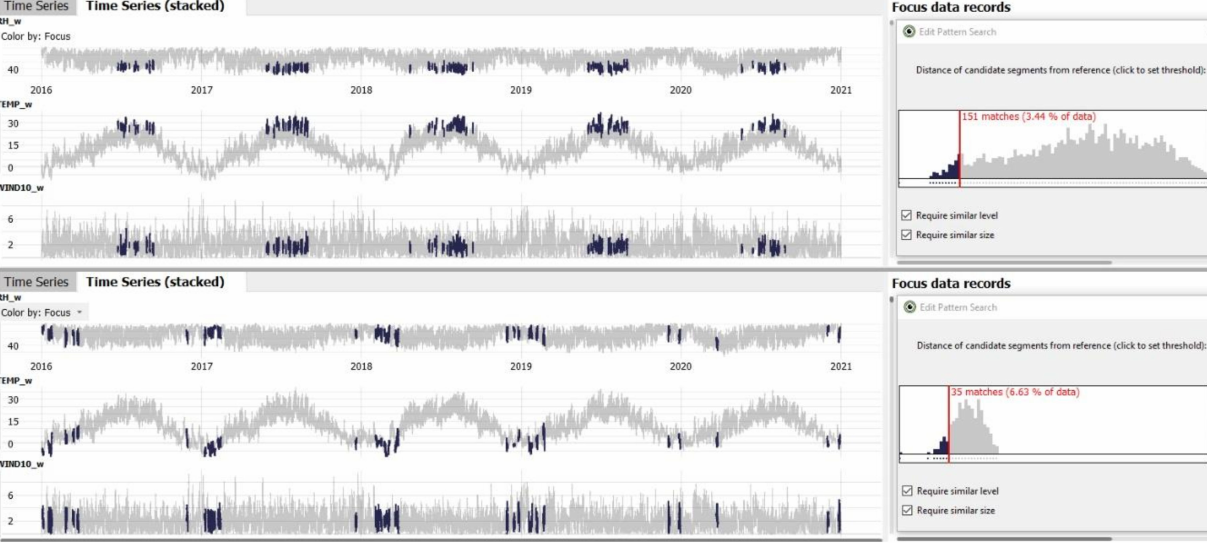
Figure 10. Multivariate pattern analysis of paired parameters for Vienna: hot events ( above ), cold events ( below